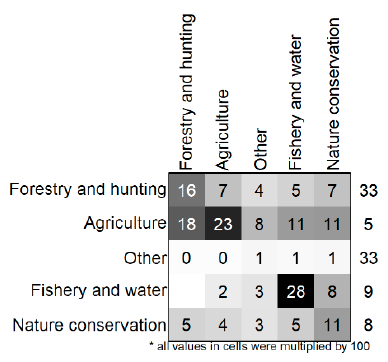
Figure 2. The matrix of cooperation among sectors in the participatory process of formulation of PUN.